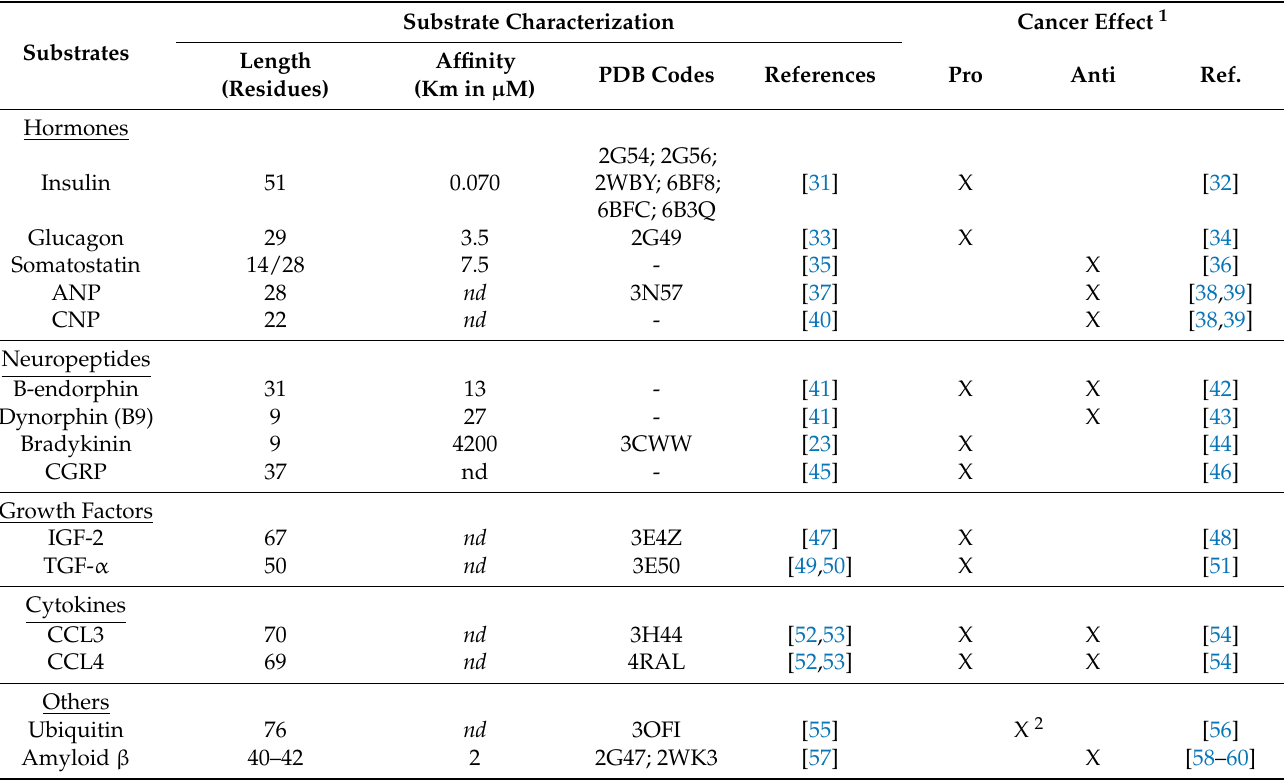
Table 1. Properties of main substrates of IDE involved in